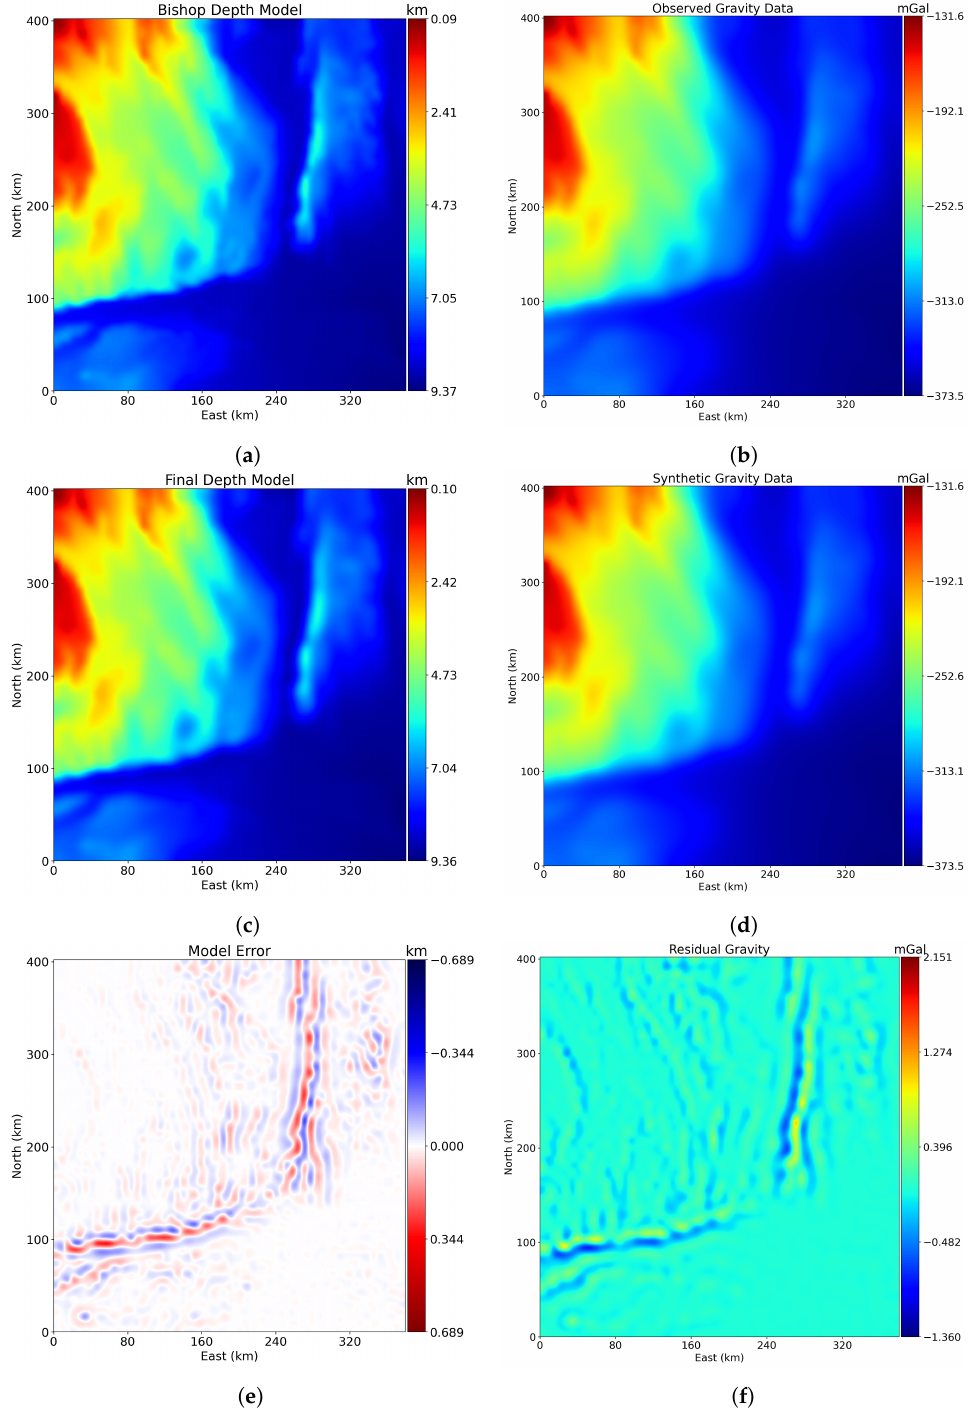
Figure 4. Inversion results for the Bishop true depth model ( a ) with gravimetric response ( b ) for the observed data vector. The final depth model after 10 iterations of CGLS ( c ) produces the gravimetric response of ( d ). The model error between the true and the final model ( e ) also produces error in the data ( f ) up to 2.15